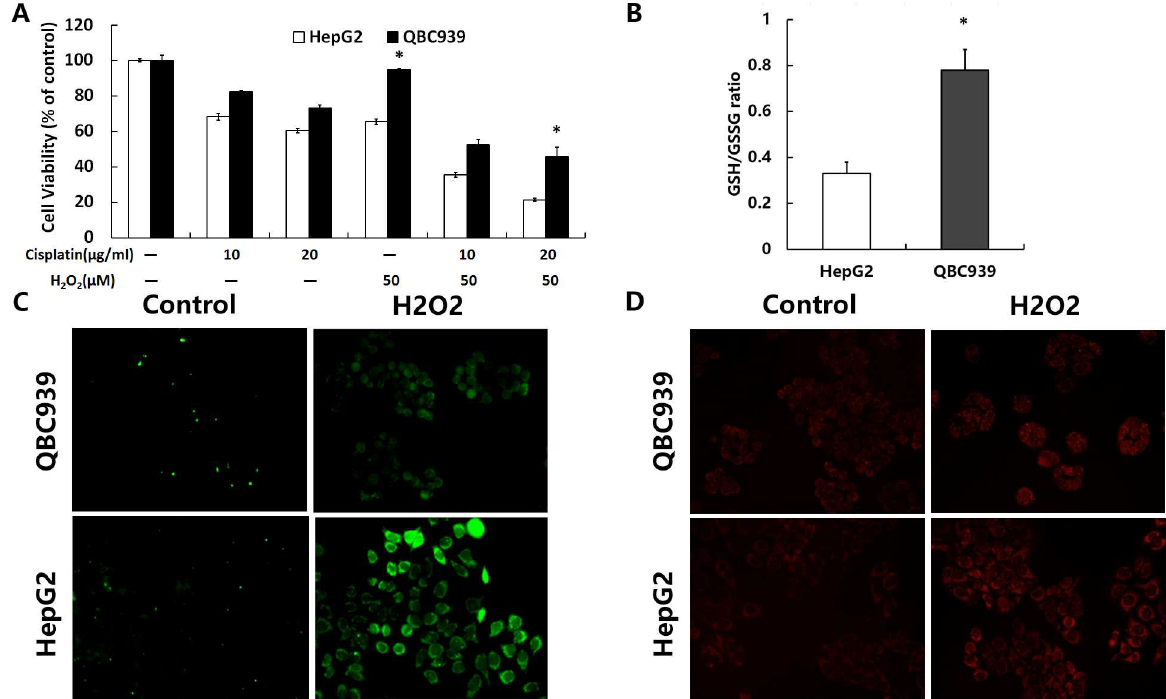
Fig 2. The antioxidant capacity of QBC939 cells were stronger than HepG2 cells. (A) Cells were treated with H 2 O 2 (50 μ M) or cisplatin(10 or 20 μ g/ml) for 24 h, and then cell viabilitywas determinedby MTT assays. (B) The intracellularGSH/GSSG ratio was determined after incubation under basal conditions. (C) Overall ROS and (D) mtROS were measuredin QBC939 cells and HepG2 cells treated with 500 μ M H 2 O 2 for 2 h ( × 200). All values are the mean ± SE. * p < 0.05betweenQBC939 cells group and HepG2 cells group.